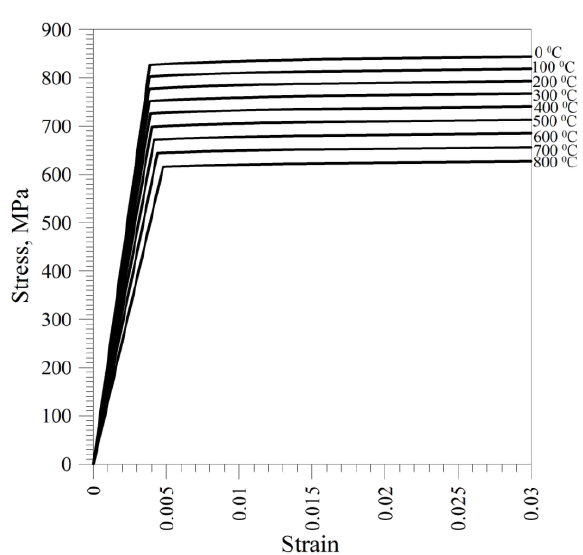
Figure 16. Tensile curves of bainite